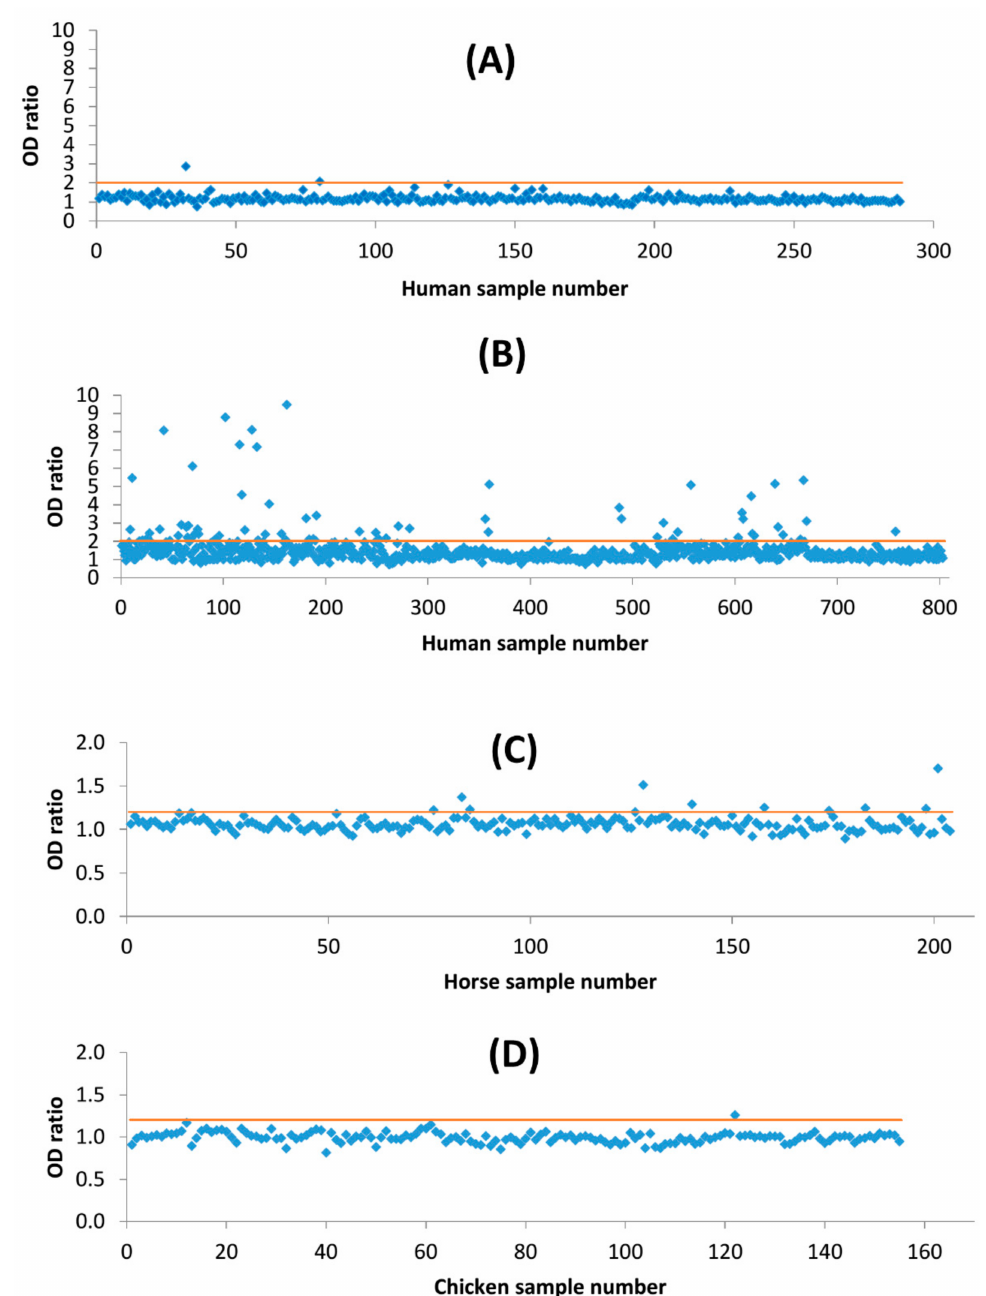
Figure 2. Optical density ratios (ODP/ODN) obtained by ELISA: ( A ) for human sera from the West Bekaa and Zahle districts, ( B ) from Akkar district, ( C ) of horse sera, and ( D ) of chicken sera from the Bekaa region. The red line represents the considered threshold (OD ratio = 2 for human sera; OD ratio = 1.2 for animal